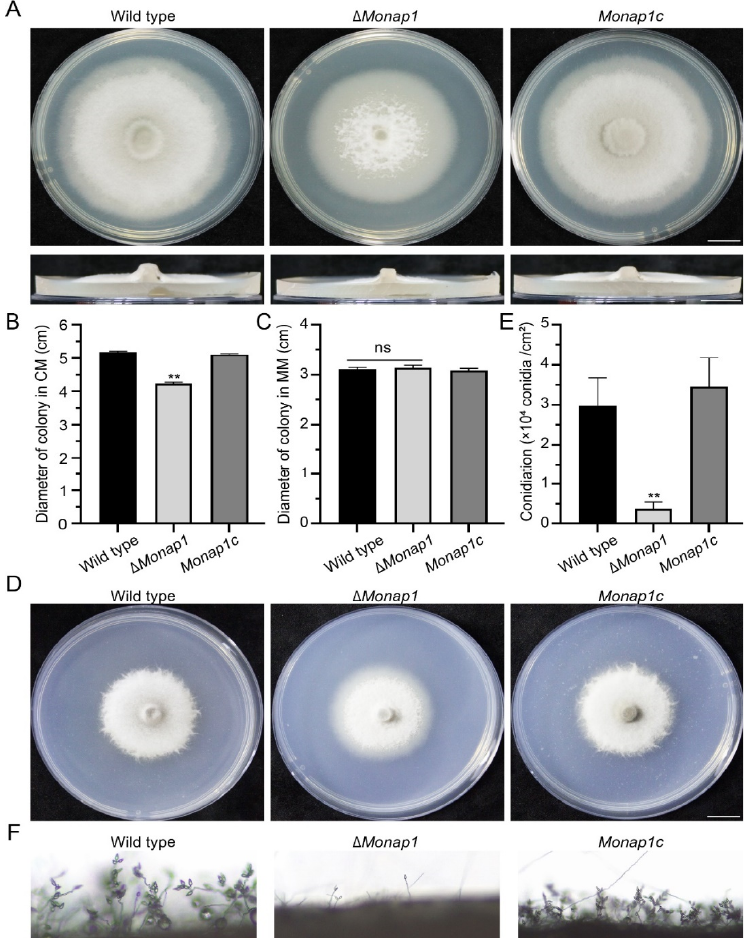
Figure 2. NAP1 is required for the growth and conidiation of M. royzae . ( A ) Colonies of the wild-type, Δ Monap1 , and MoNAP1 complemented strains of Δ Monap1 ( Monap1c ). Bar, 1 cm. ( B ) Mycelial growth (cm) of the wild-type, Δ Monap1 and Monap1c colonies in CM. n = 5 independent biological replicates. Error bars represent the standard deviations. The data were analyzed by GraphPad Prism 8.0 and significant differences compared with the wild type were estimated by multiple t tests: ** p < 0.01. ( C ) Mycelial growth (cm) of the wild type, ∆ Monap1 and Monap1c colonies in MM. n = 5 independent biological replicates. Error bars represent the standard deviations. The data were analyzed by GraphPad Prism 8.0 and significant differences compared with the wild type were estimated by multiple t tests: ns, p > 0.05. ( D ) Colonies of the wild type, ∆ Monap1 , and Monap1c in MM. Bar, 1 cm. ( E ) Conidiation of the wild type, ∆ Monap1 and Monap1c strains in CM. n = 5 independent biological replicates. Error bars represent the standard deviations. The data were analyzed by GraphPad Prism 8.0 and significant differences compared with the wild type were estimated by multiple t tests: ** p < 0.01. ( F ) Conidiophore development of M. oryzae strains. Bar, 50 µ